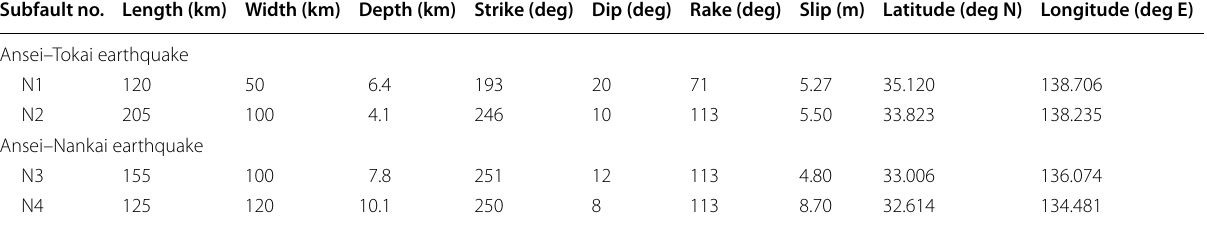
Table 1 Fault parameters of the 1854 CE Ansei–Tokai and Ansei–Nankai earthquakes (An’naka et al.